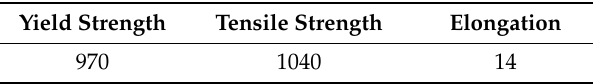
Table 2. Mechanical properties of base metal (wt